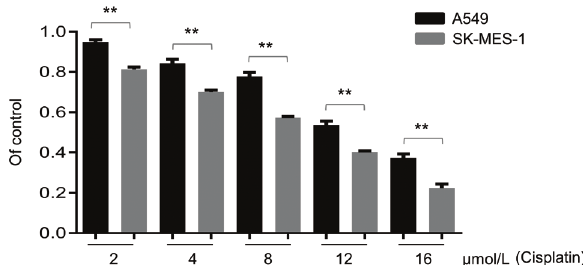
Fig. 2. The migration capacity of A549 was higher than that of SK-MES-1. A, the A549 and SK-MES-1 cell lines treated with cisplatin (2, 4, 8, 12, and 16 μmol/L) and placed into 48-well plates with fresh medium. The migration capacity of cells was detected by scratch test. Data represent mean ± SD of three independent experiments. B, the A549 and SK-MES-1 cell lines treated with cisplatin (2, 4, 8, 12, and 16 μmol/L) were placed into 48-well transwell plates and incubated with fresh medium. The invasion capacity of cells was determined by invasion kit. Data represent mean ± SD of three independent experiments ( P <